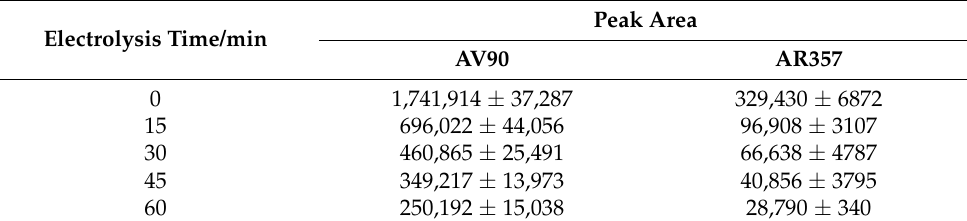
Table 3. Variation of the detected chromatographic peak areas for AV90 and AR357 substrate components by time of electrolysis.